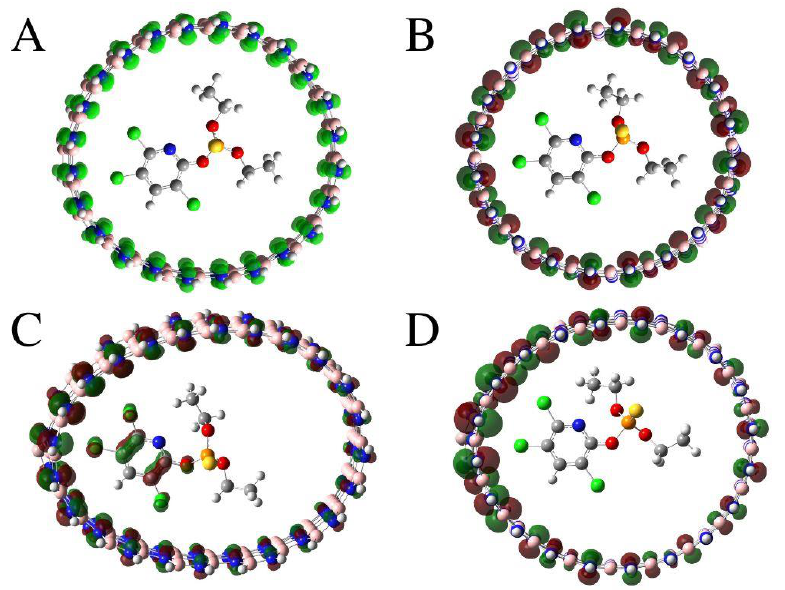
Figure 5. The HOMO diagrams of ( A ) BNNT(12,12) + chl, ( B ) BNNT(20,0) + chl, ( C ) Al-BNNT(12,12) + chl, and ( D ) Al-BNNT(20,0) + chl.